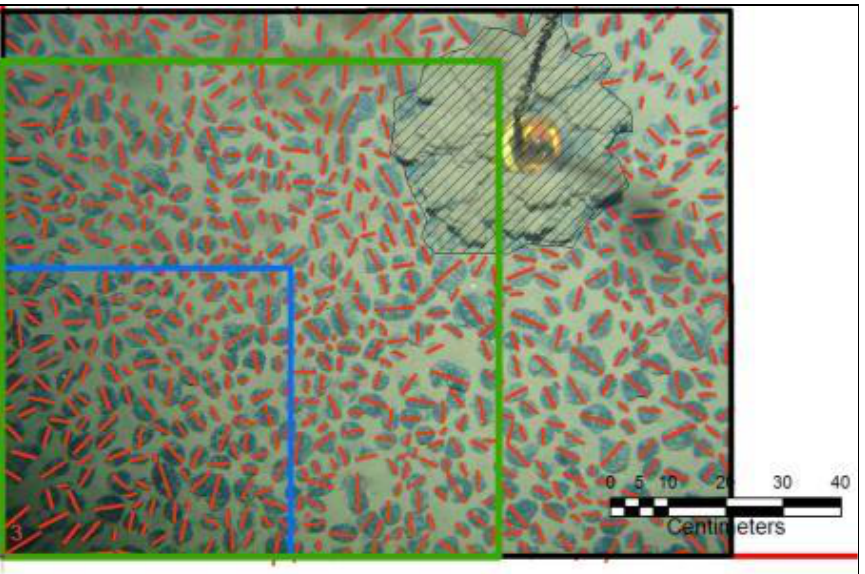
Figure 18. Example of long-axis estimate (LAE) measurements from a photograph taken from box-core-mounted camera. Source: Lipton et al. [12]. The blue frame is an example of an area that would be collected by a 0.25-m 2 box corer, and the green frame is an area that would be sampled by a 0.75-m 2 box corer.